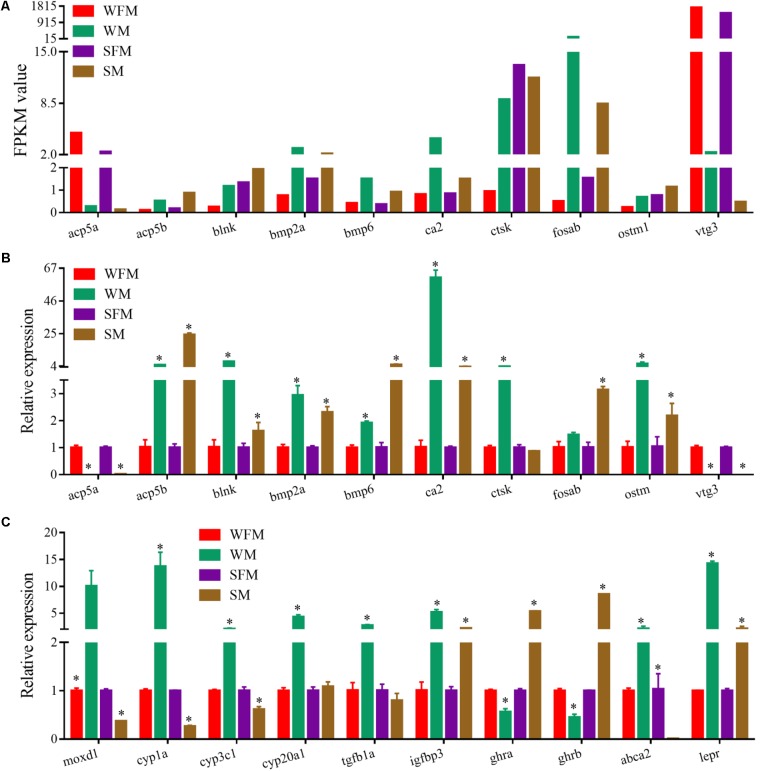
Verification of the transcriptome data by qRT-PCR. (A) Profile of Illumina sequencing value for selected genes with normalized expression data (FPKM value). (B,C) Relative expression of selected genes by qRT-PCR. Values are indicated as means ± standard deviation (SD). The data was assessed using a Student’s t-test. A probability P < 0.05 was considered statistically significant. ∗P < 0.05.